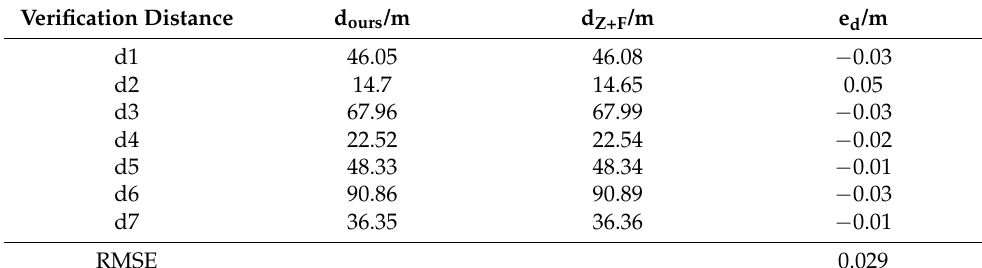
Table 1. Plane accuracy comparison.